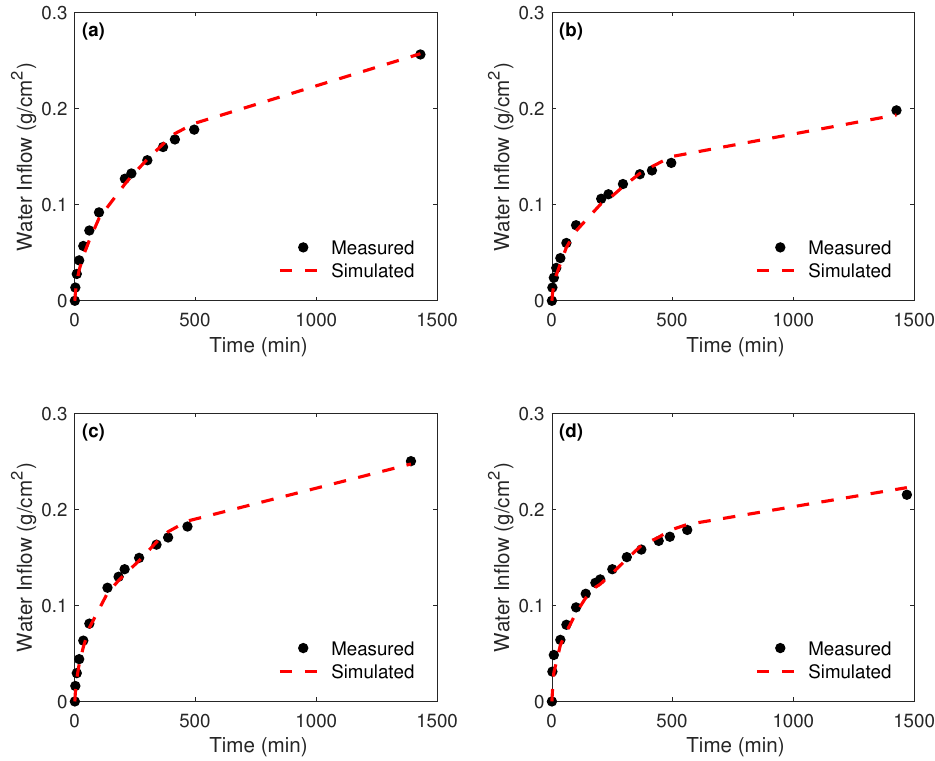
Figure 7. Cumulative measured and simulated water inflow. Results are shown for samples cured in standard condition. ( a ) GGBS0; ( b ) GGBS45; ( c ) GGBS60; and ( d )